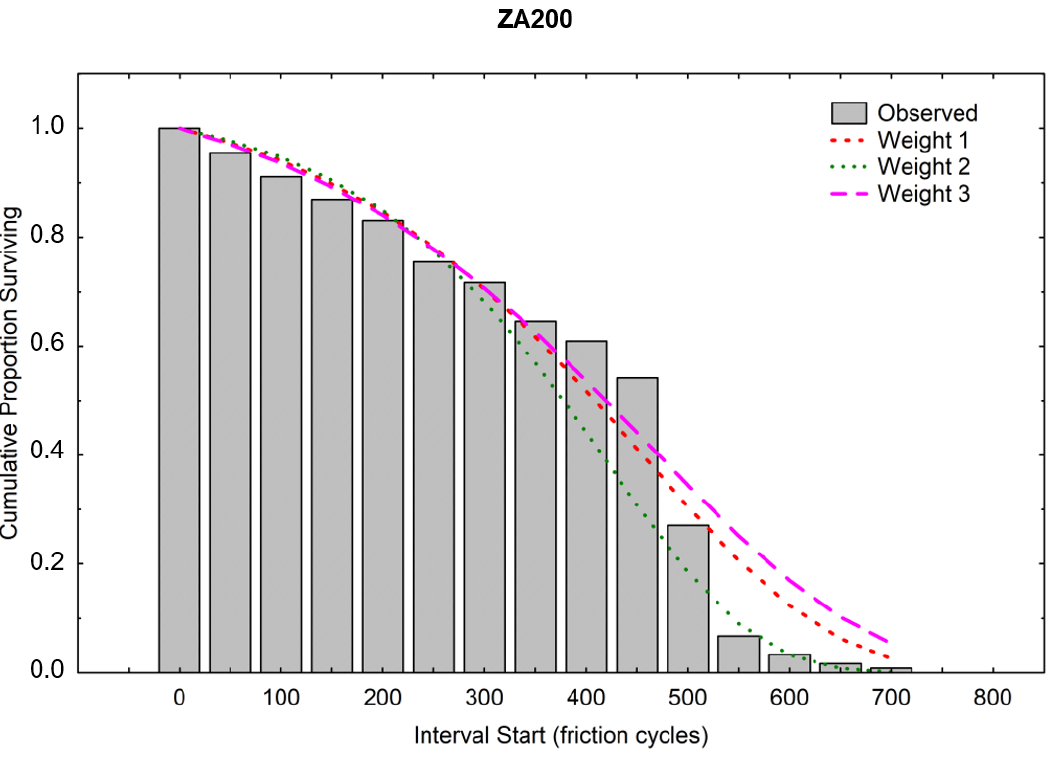
Figure 13. Cumulative proportion surviving (ZA200).